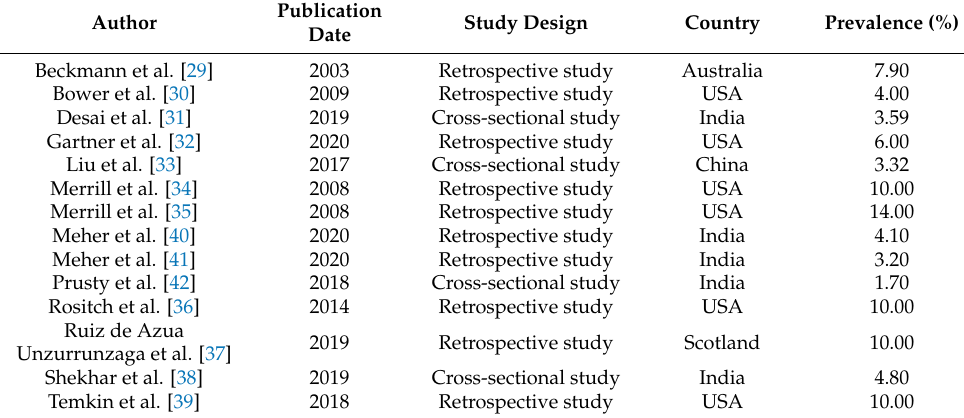
Table 3. Prevalence of hysterectomies by country in women under